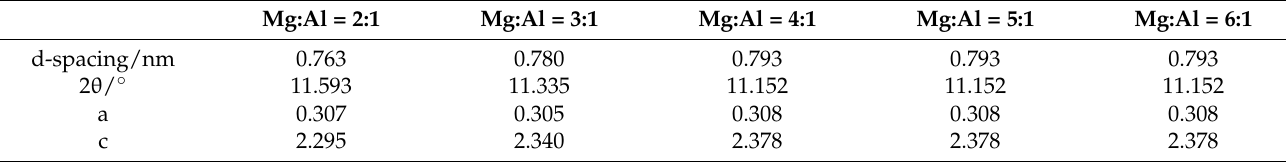
Table 1. Layer spacing of the crystal plane under different ratios of